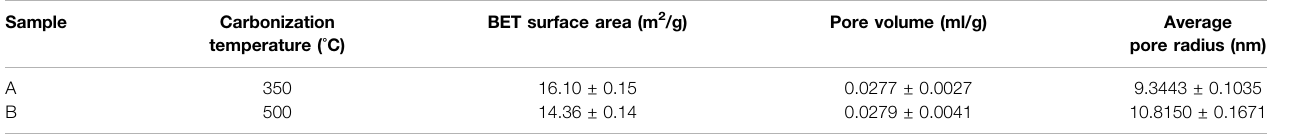
TABLE 2 | Effect of carbonization temperature on speci fi c surface area.